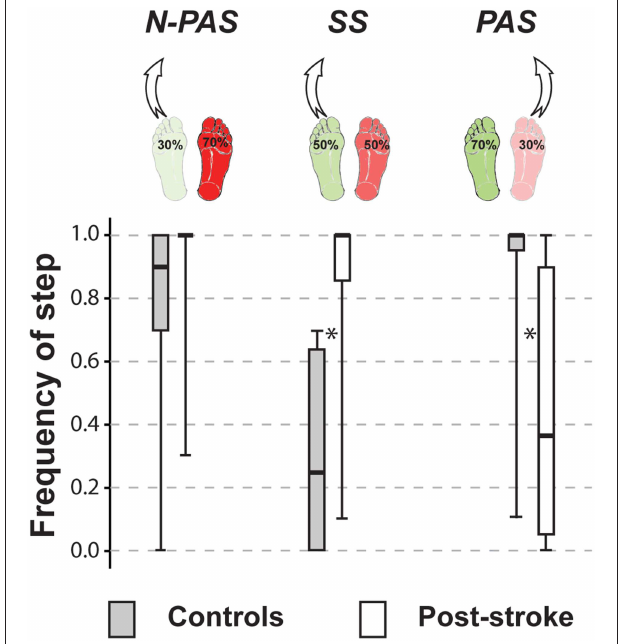
FIGURE 3 | Frequency of step. The median (thick line) of the step frequency is presented for each group and each condition in which they were compared. Boxes represent 25 and 75th percentile. Bars represent min and max values. *Indicates a difference between groups at p < 0.05. (SS: U = 16.5, Z = − 4.568, p < 0.001; PAS: U = 46.5, Z = 3.613, p <